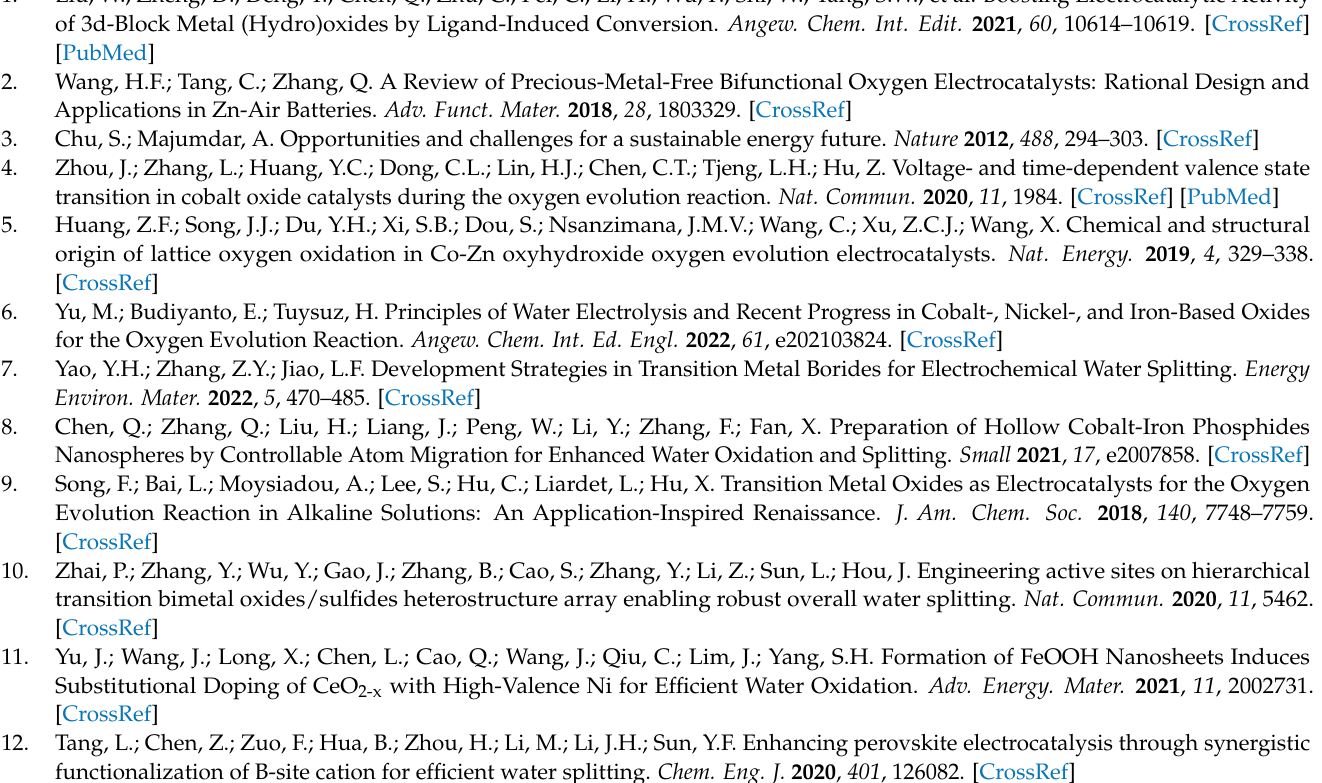
Figure S2: N 2 adsorption–desorption isotherms of LNO and 0.25Fe-LNO; Figure S3: TEM image of 0.25Fe-LNO; Figure S4: HRTEM image of LNO; Figure S5: HAADF-TEM image of 0.25Fe-LNO and the corresponding elemental mapping images; Figure S6: XPS survey spectra of LNO and 0.25Fe-LNO; Figure S7: (a) LSV of LNO, FeOOH, Fe-LNO and IrO 2 samples. (b) The corresponding Tafel plots; Figure S8: (a) LSV of LNO, FeOOH and 0.25Fe-LNO samples without Ketjenblack carbon. (b) The corresponding Tafel plots; Figure S9: CV curves measured from 20 mV S − 1 to 120 mV S − 1 of (a) LNO, (b) 0.125Fe-LNO, (c) 0.25Fe-LNO, (d) 0.5Fe-LNO, (e) 0.75Fe-LNO and (f) FeOOH; Figure S10: ECSA-normalized LSV of LNO, xFe-LNO, FeOOH and RuO 2 ; Figure S11: (a) LSV of LNO, FeOOH, 0.25Fe-LNO and 0.25Fe/LNO samples. (b) The corresponding Tafel plots. (c) Linear fits of half capacitive currents versus scan rates for the extraction of the double-layer capacitances. (d) Nyquist plots; Figure S12: The LSV of Ni foam; Table S1: The fitting parameters of Nyquist plots; Table S2: TOF @ 1.60 V vs. RHE (S − 1 ) of the LNO, xFe-LNO and FeOOH samples. Table S3: Atomic ratios